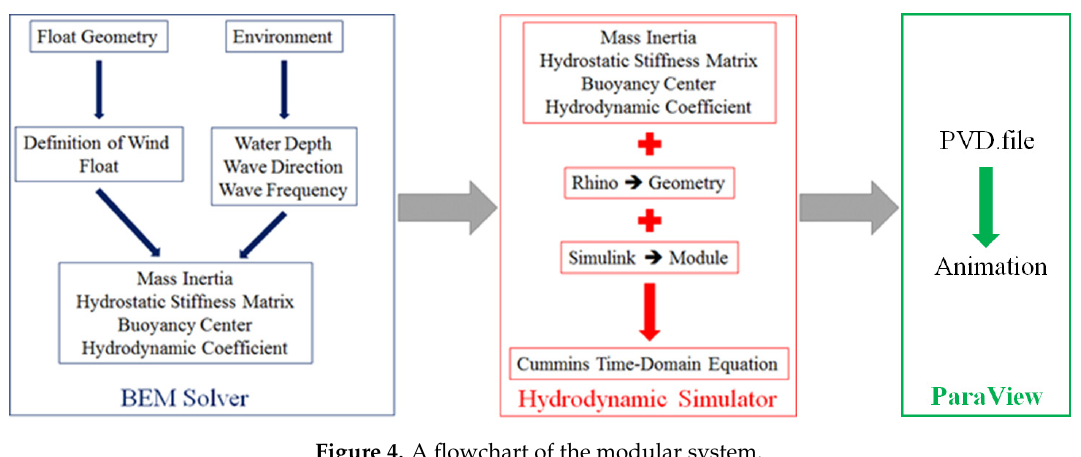
Figure 4. A flowchart of the modular system.